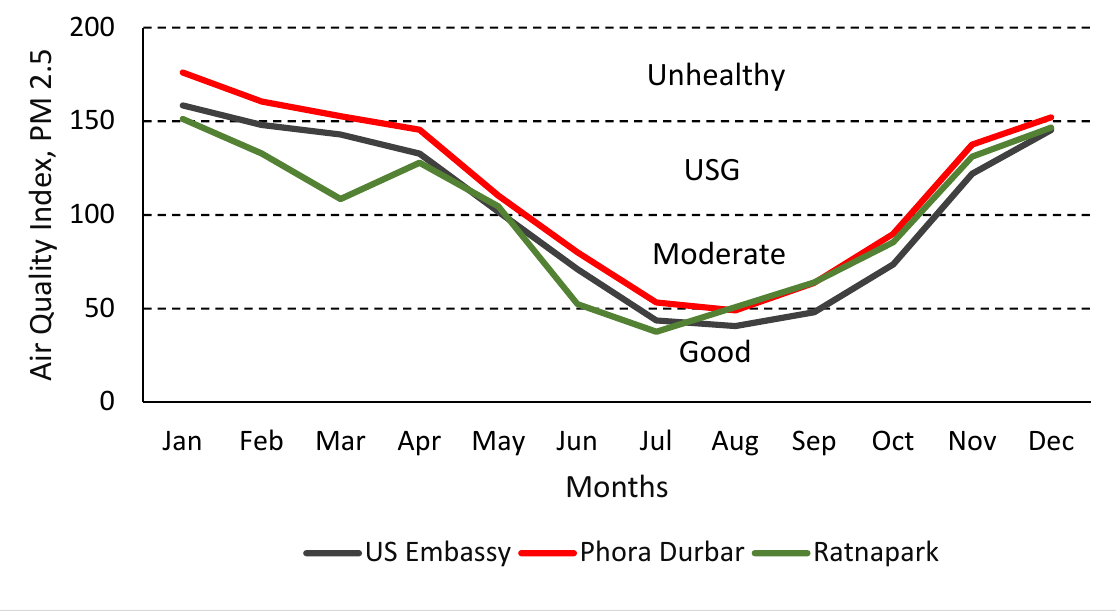
Figure 5. Monthly Air Quality Index (AQI) trends from three air quality monitoring stations in KMC.